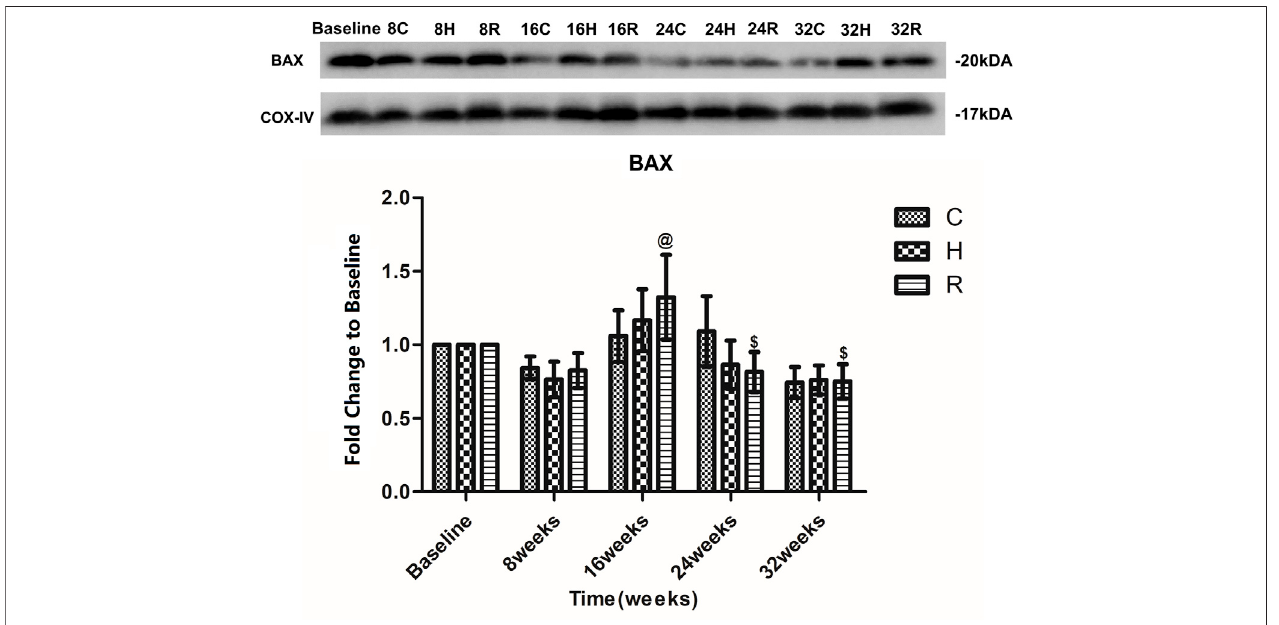
FIGURE6| Age and exercisetraining effects onBAX levelsinmitochondria ofsoleusmuscle,wereevaluatedbyWestern blot.@Signi fi cantdifferentfrom8 weeks and other weeks; $ Signi fi cant different from 16 weeks and other weeks. ( p < 0.05).